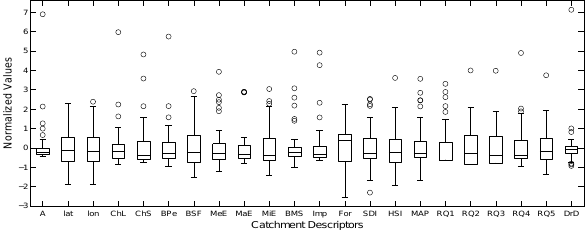
Fig. 2. Normalized values of catchment descriptors (see also Table 1 for label description) used in the study; box plots report minimum and maximum values (whiskers), 25th, 50th and 75th percentiles (box), and outliers